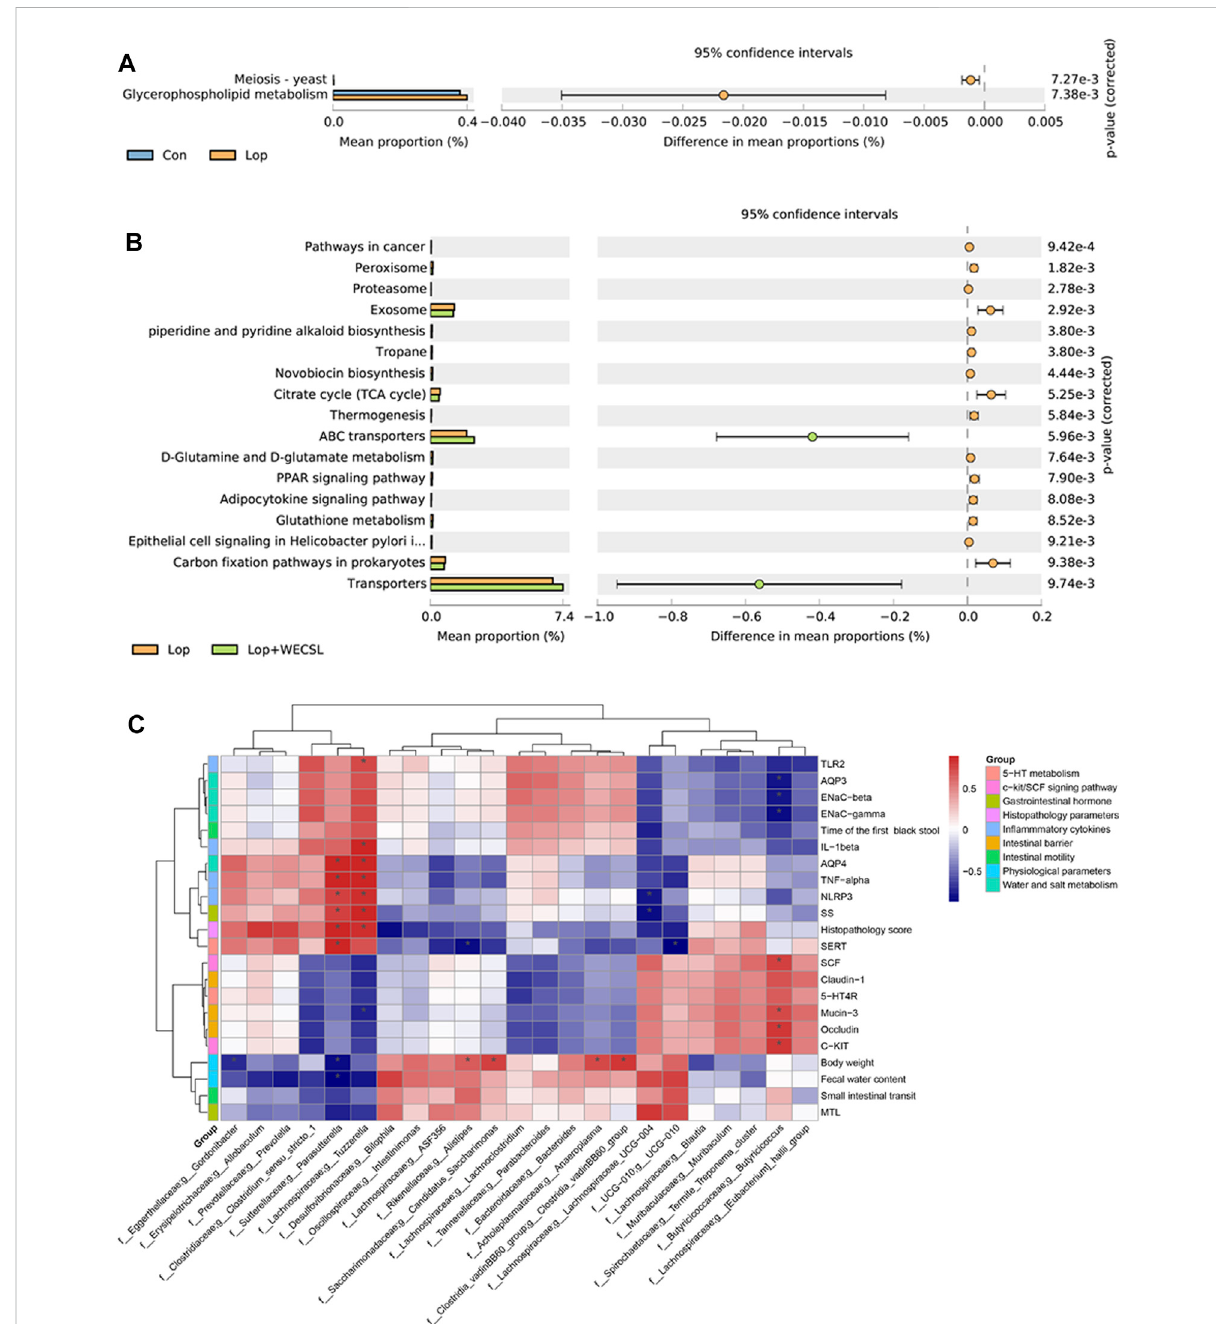
FIGURE 7 WECSL affected metabolic pathways of gut bacteria and correlation between bacterial abundance and constipation-related markers. (A,B) KEGG analysis of differences in the composition of metabolic pathways between Con and Lop (A) , Lop and Lop + WECSL (B) . (C) Spearman correlation test was used for correlation analysis, and the p -value was corrected using the Benjamini – Hochberg test (***FDR < 0.001, **FDR < 0.01, and *FDR < 0.1). Red and blue colors represent signi fi cant positive correlations and negative correlations,